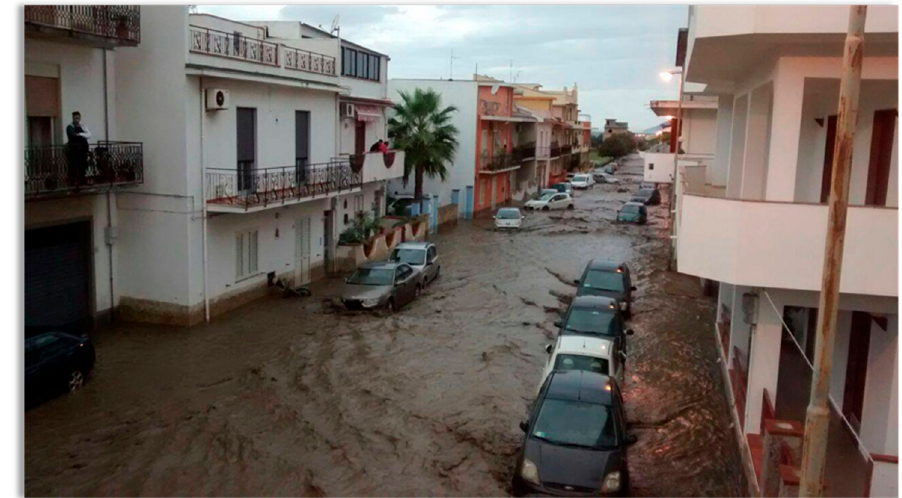
Figure 2. Historical inundated area during the event of October 2015, with evidence of the flooding source points (red circles).